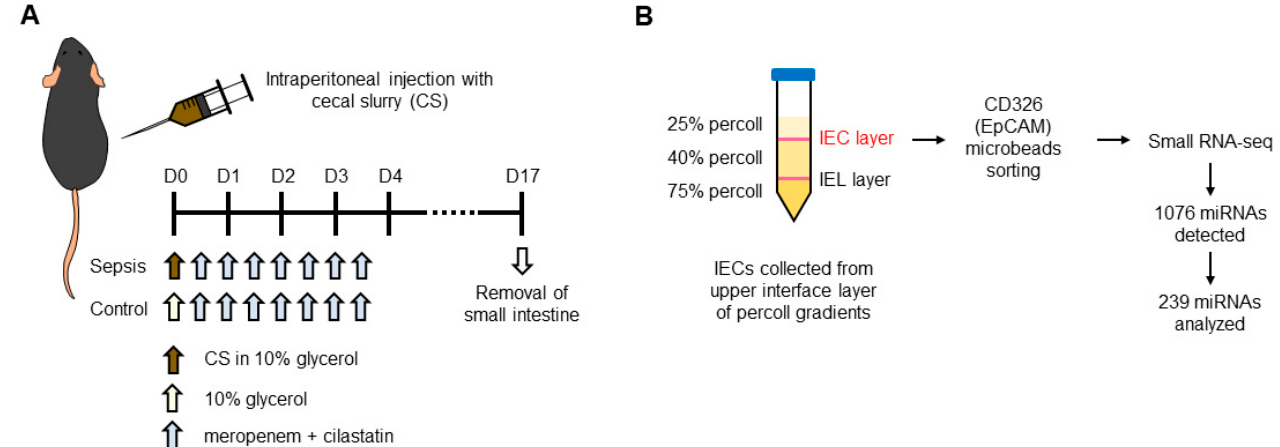
Figure 1. Experimental design of a mouse model of sepsis. ( A ) Mice were treated with cecal slurry (CS) by intraperitoneal injection to induce sepsis. CS was collected from naïve wild-type mice and dissolved in 10% glycerol in PBS. Sham mice were treated with 10% glycerol in PBS. After treatment, both sham and sepsis mice were treated with a cocktail of antibiotics (meropenem and cilastatin). At day 17 after treatment of CS, mice were euthanized, and small intestine tissues were collected for IEC isolation. ( B ) IECs were isolated from the small intestines by the methods of Percoll density gradients (25, 40 and 75%). Small intestinal tissues were separated from mice and Peyer’s patches, and fat tissues were then removed. The tissues were opened, washed with ice-cold PBS, and incubated with RPMI-1640 containing FCS (10%) and EDTA (2 mM). After filtering with 70- µ m cell strainer, the filtered cell suspension was centrifuged, resuspended in 40% Percoll, and applied to Percoll density gradients. After centrifugation, IECs were collected from the interface between 25 and 40% of Percoll gradients. Isolated IECs were further enriched using magnetic sorting system with EpCAM or CD326 microbeads. MiRNAs of the isolated SIECs were sequenced using the high-throughput Ion Xpress™RNA-Seq platform. A total of 1076 miRNAs were detected, and 239 miRNAs that were detected across all samples (i.e., threshold detection hit of >0) were further analyzed for differential and downstream functional analysis.